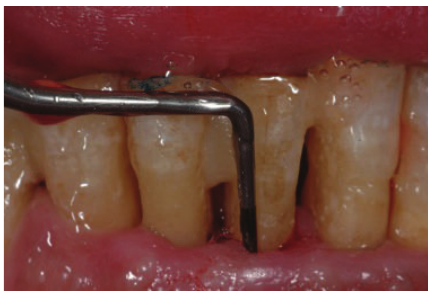
Figure 2: Sample of periodontal probe on osteoporotic patients without